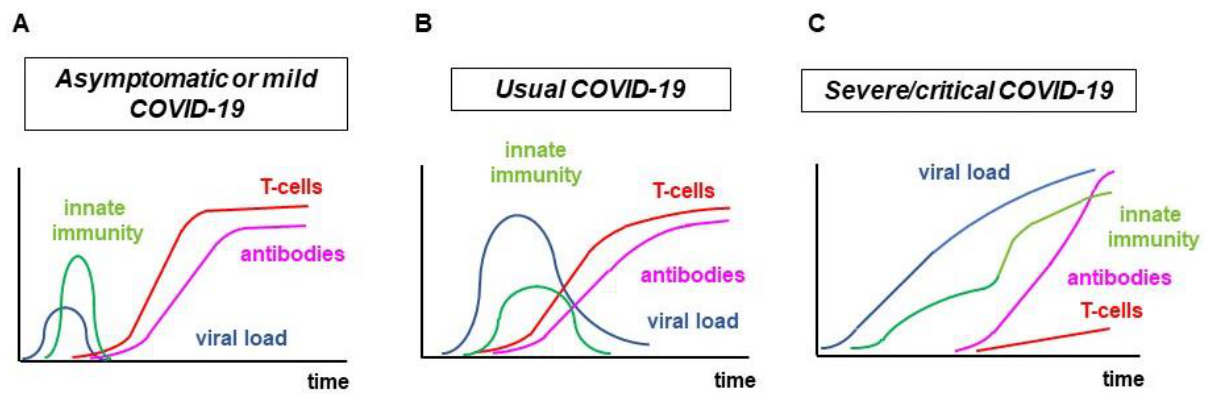
Figure 1. Immunological processes in COVID-19 with different severity. ( A ). asymptomatic or mild COVID-19; ( B ). moderate/usual COVID-19; ( C ). severe/critical COVID-19.